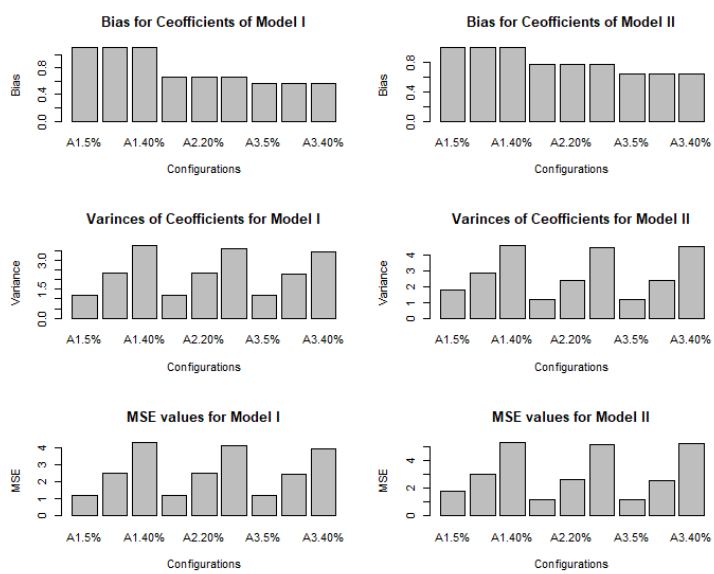
Figure 4. Fitted curves to observe the quality of the estimates for 𝑛 = 100,ℒ = 5%,40% .